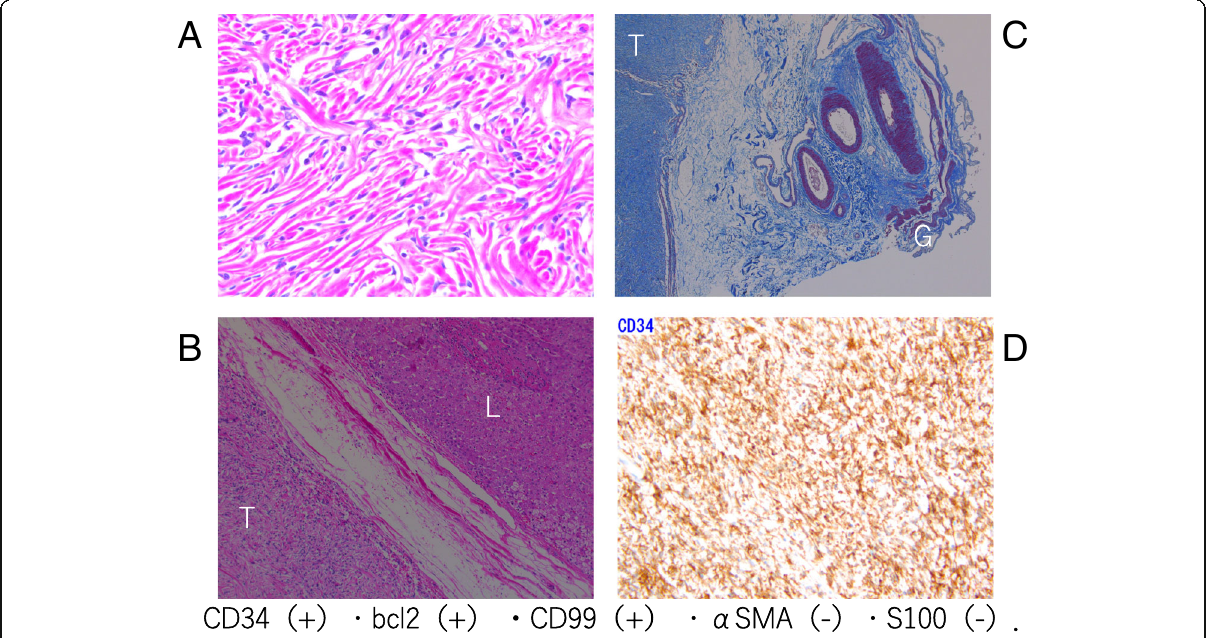
Fig. 6 Histological findings of the resected specimen show a the microscopic appearance of Hematoxylin and Eosin-stained spindle-shaped tumor cells with elongated nuclei (40×) and b of Masson ’ s Trichrome staining (40×). c The tumor (T) was free from the gallbladder (G), and from the liver (L). d Immunohistochemical staining for CD34 (100×)